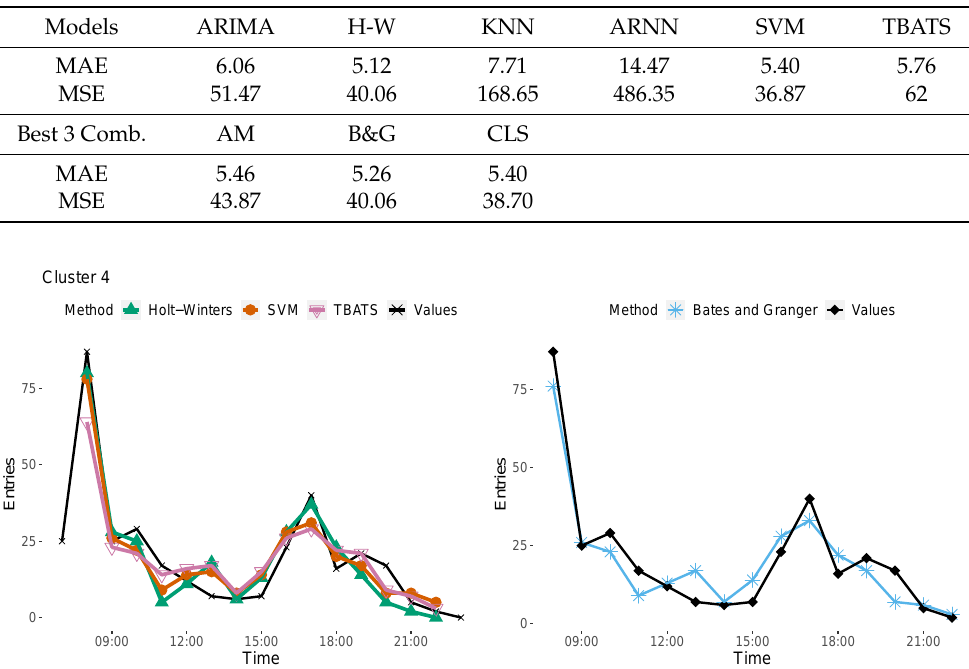
Figure 14. Cluster 4: three last days of historical data plus one-day predictions and real values ( left ). On the ( right ), a close-up of the predictions and real values is shown. Table 5. MAEs and MSEs for each model in Cluster 4 for one-week historical and one-day predictions, and for the different combinations of the best three models.